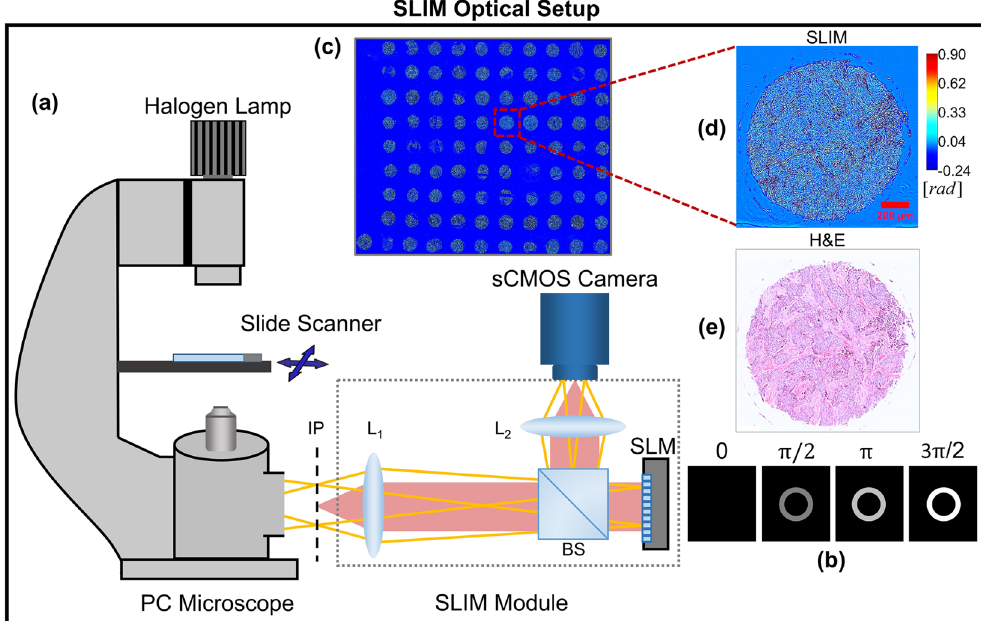
Figure 1. ( a ) The SLIM module added on to a commercial phase contrast microscope. ( b ) Four frames are acquired to compute one phase image by modulating the phase difference between scattered and incident light using a spatial light modulator (SLM). (c) An image of the whole slide scanned using SLIM. ( d ) Example of a TMA core SLIM image. ( e ) Bright field image of the same core after H&E staining. BS, beam splitter; L 1 -L 2, lenses; IP, image